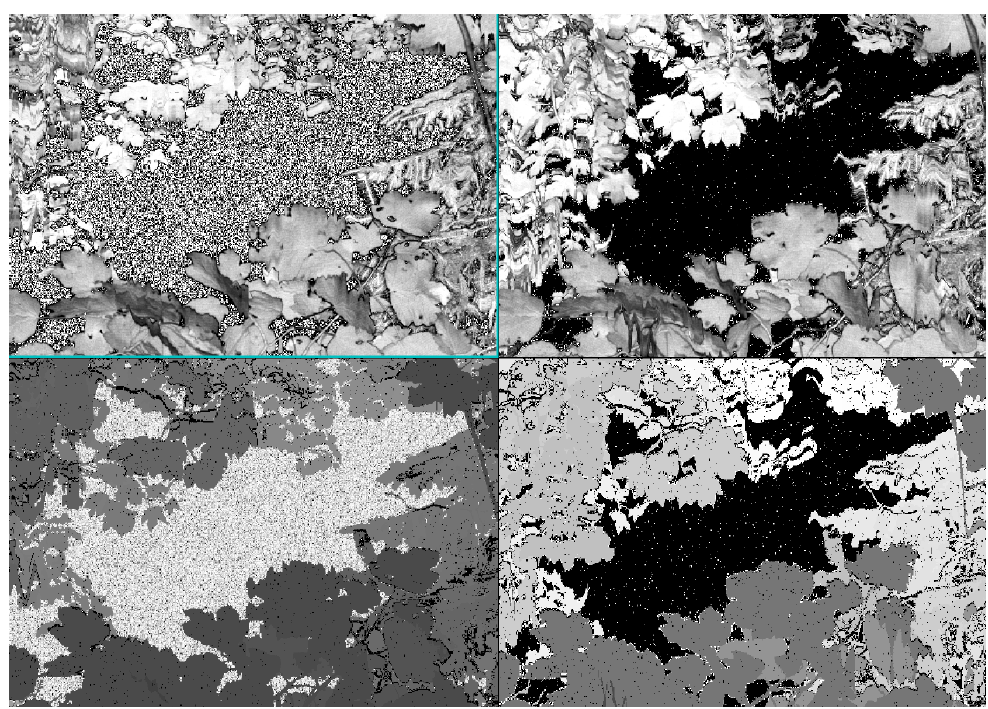
Figure 2. Range and intensity images of the test scans without ―clear sky‖ filtering ( Left ) and with ―clear sky‖ filtering ( Right ). Intensity images are displayed above their respective range image. The images’ grayscales were stretched to maximize the contrast between sky and canopy, with black and white corresponding to minimum and maximum values